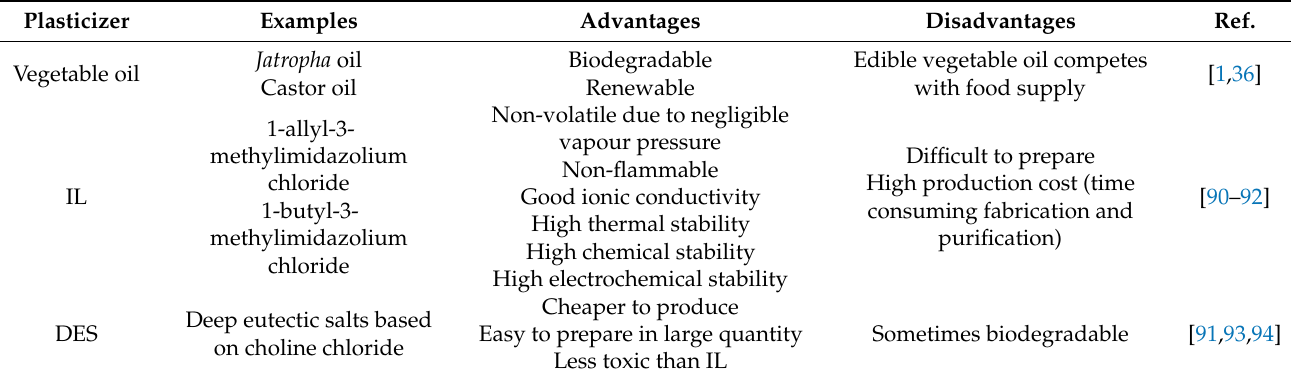
Table 2. Advantages and disadvantages of